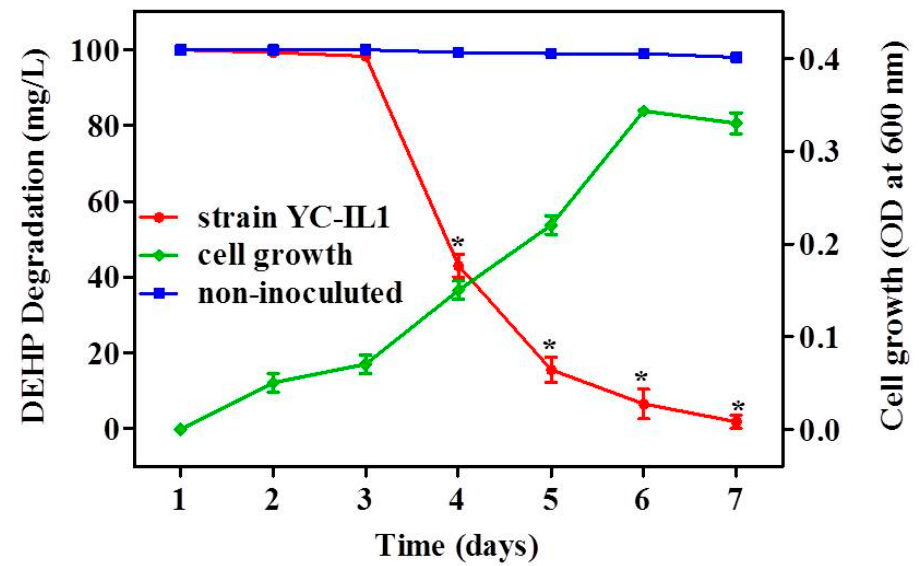
Figure 2. DEHP (di-2-ethyl hexyl phthalate) degradation rate and cell growth of YC-IL1 under optimized conditions. Data represent the mean ± SEM from at least three experiments. * indicates the significant difference ( p < 0.05; two-way repeated measure ANOVA followed by Bonferroni post-test) between the media inoculated with strain YC-IL and control (non-inoculated media).